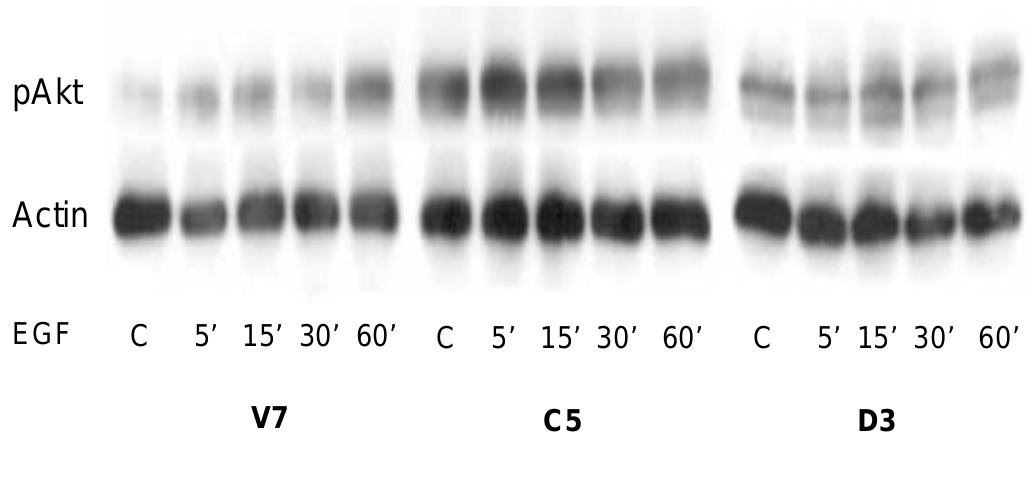
Figure 4. Time course of the effects of EGF on Akt activation in EL4 cell lines. Cells were serum starved 24 hours prior to EGF treatment. Serum-starved cells were treated for indicated times with or without (“C”) 10 nM EGF. Equalized protein (100 µ g) from whole- cell lysates was resolved by SDS-PAGE and transferred to a PVDF membrane.